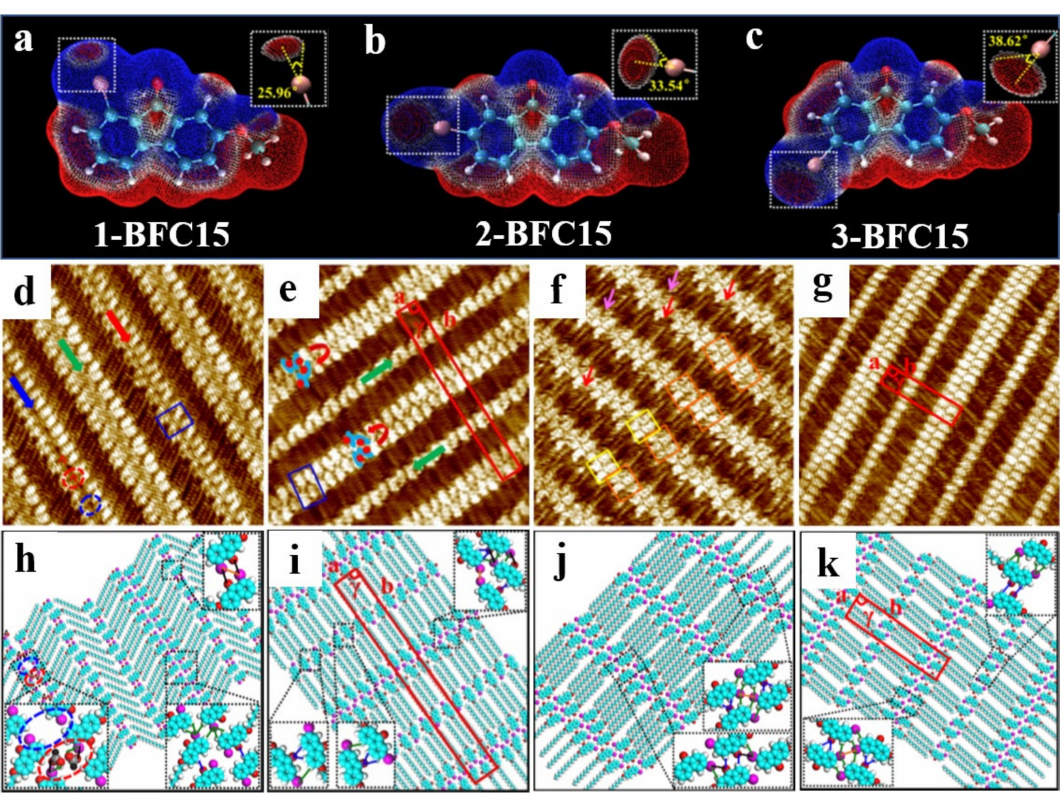
Figure 10. ( a – c ) Calculated 3D ESP maps of 1-BFC15, 2-BFC15, and 3-BFC15 molecules. ( d – g ) High- resolution STM images show the self-assembled alternate-I ( d , 1-BFC15), alternate-II ( e , 2-BFC15), lamellar ( f , 3-BFC15), and alternate-III patterns ( g , 3-BFC15) at the 1-octanoic acid / HOPG interface, respectively. Scanning areas: 20 × 20 nm 2 . ( h – k ) Proposed molecular models of ( d – g ). Intermolecular interactions are reflected in the enlarged insets. Reproduced from [82] with permission from the American Chemical